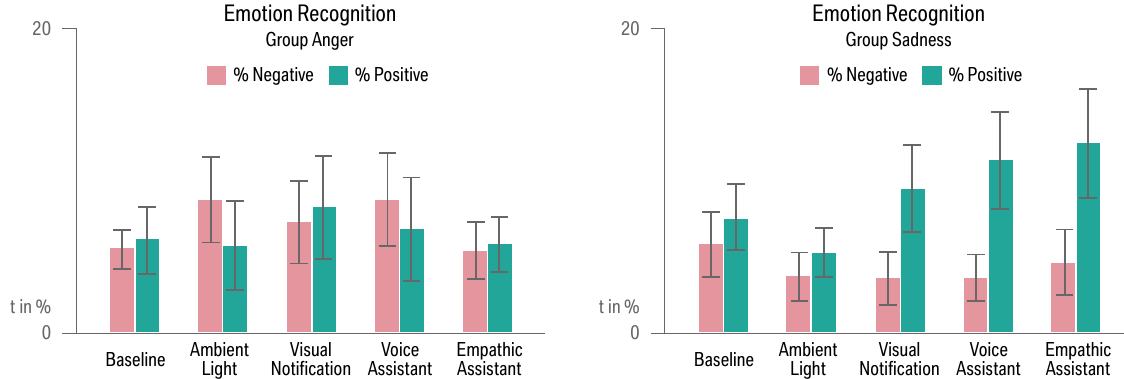
Figure 7. Positive and negative valence assessed with facial emotion recognition. Group Anger shows more negative emotions than group Sadness . Positive effects of strategies can be observed by increased display of positive